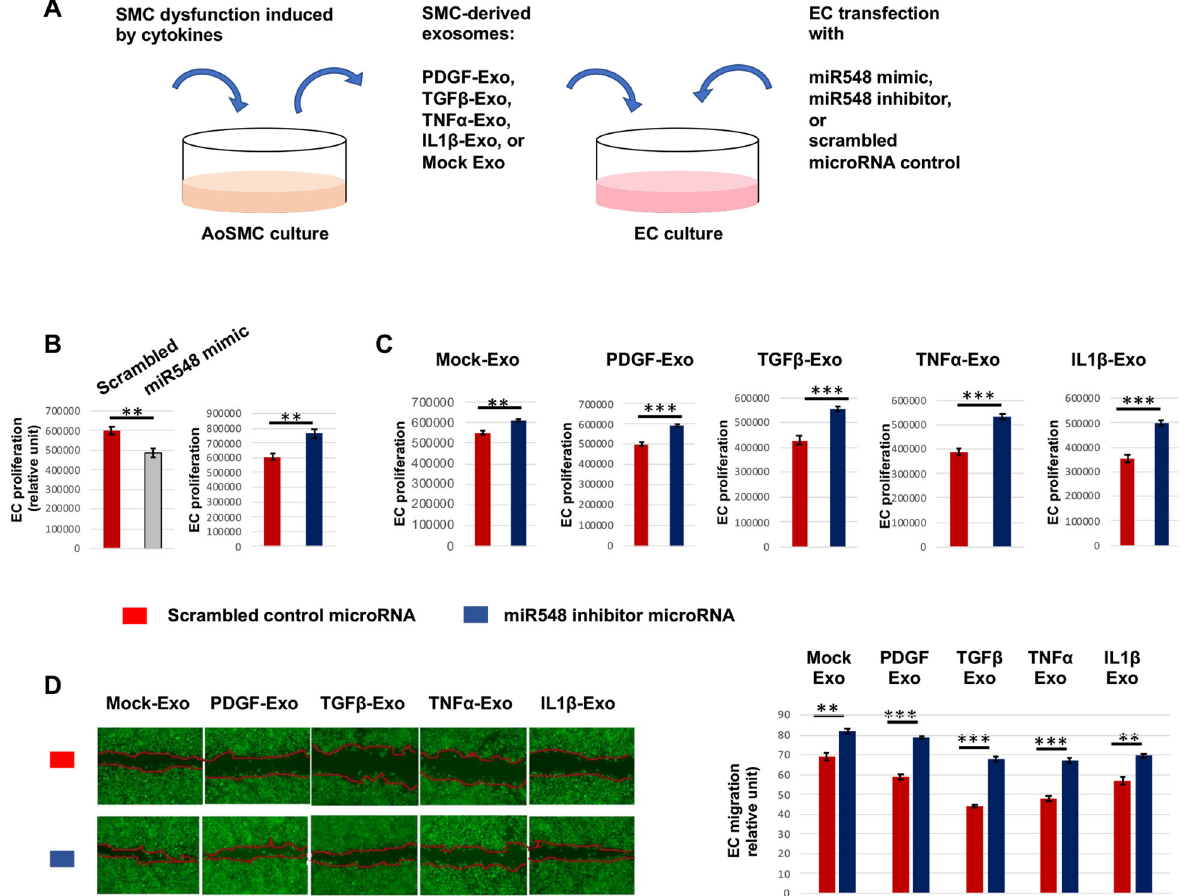
Fig. 5 Effect of miR548ai inhibitor on EC proliferation and migration. A Schematic of the experimental design for this fi gure. B EC proliferation in full medium. ECs cultured in the full medium were transfected with a miR548ai mimic or inhibitor or scrambled microRNA (control) prior to Cell Titer-Glo assay. C and D EC proliferation and migration (respectively) in the presence of SMC-derived exosomes. Exosomes were isolated from the conditioned media of AoSMCs that were starved and then stimulated with a cytokine (same concentration as indicated in Fig. 1). The exosomes and miR548ai inhibitor (or scrambled microRNA) were added to ECs. Migration was measured as an increase in cell-reoccupied gap space 24 h (vs. 0 h) after scratching. Calcein was used to render cells fl uorescent for imaging at the end of the 24 h experiment. Data are presented as mean ± SD ( n = 3 replicates). Student t -test: ** P < 0.01, *** P < 0.001. Cell Death Discovery (2021)